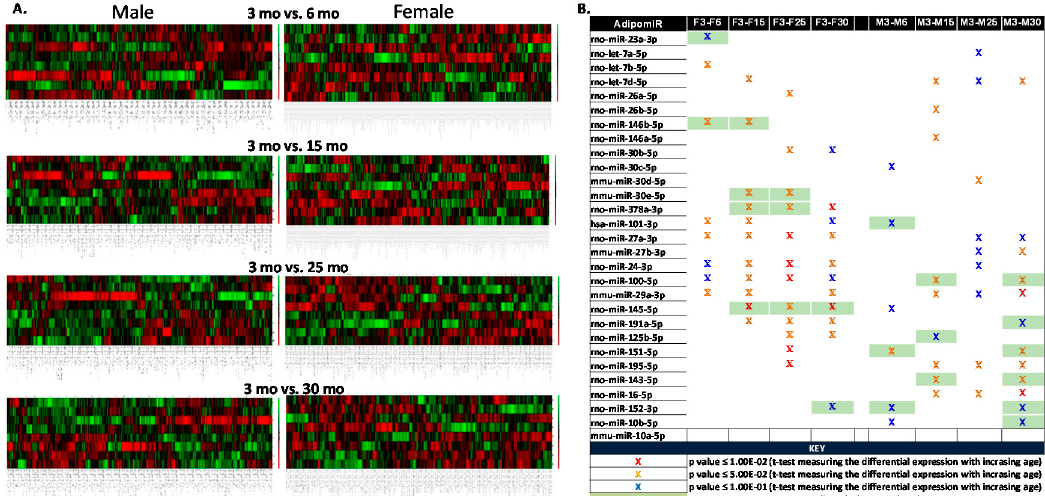
Figure 1. Longitudinal changes in adipose-specific microRNAs (adipomiRs): Small-RNA sequencing was performed on visceral adipose tissue obtained from all ages in both the sexes ( n = 4/age/sex). ( A ) Heat map depicts the differentially expressed adipomiRs with age (6, 15, 25 and 30 month (mo in the figure) old) compared to 3 month old male and female FBN rats. ( B ) A list of the differentially expressed adipomiRs in both sexes. Green shade indicates downregulation of the respective adipomiR. Red X— p -value ≤ 1.00 × 10 − 2 ; orange X— p -value ≤ 5.00 × 10 − 2 and blue X— p -value ≤ 1.00 × 10 − 1 ( t -test measuring the differential expression with increasing age compared to 3 mo rats in both sexes).